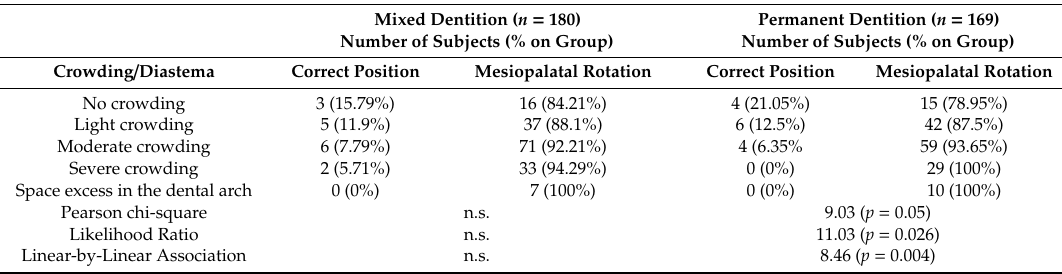
Table 4. Distribution of data for crowding and presence of rotated upper first molar (UFM), with corresponding